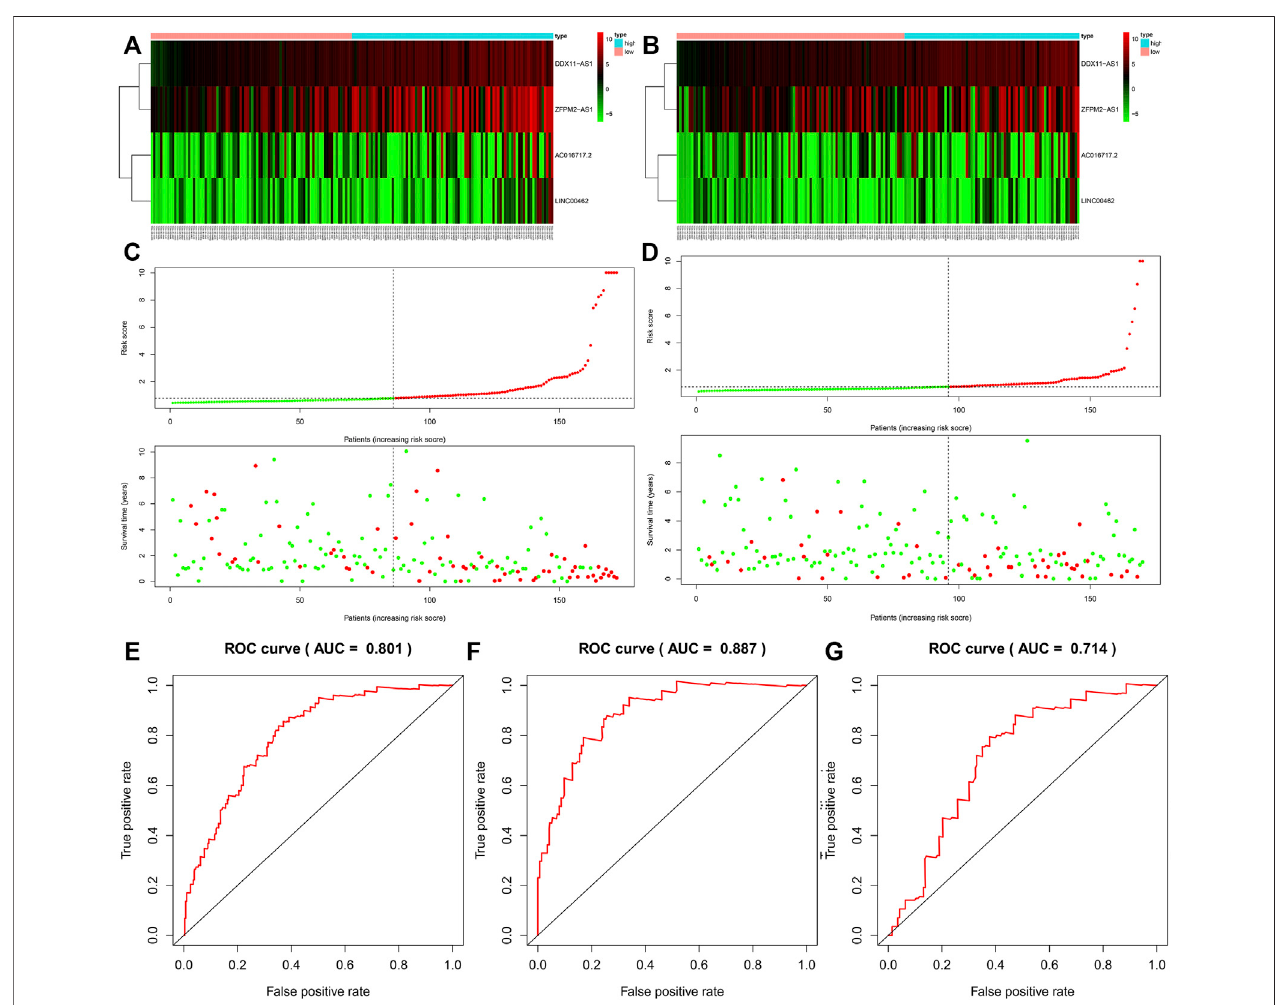
FIGURE 4 | The survival rate of the high-risk group and the low-risk group in the training group (A) and the test group (B) . The survival status of the training group (C) and the test group (D) . The ROC curve of the whole group (E) , training group (F), and the test group (G) .